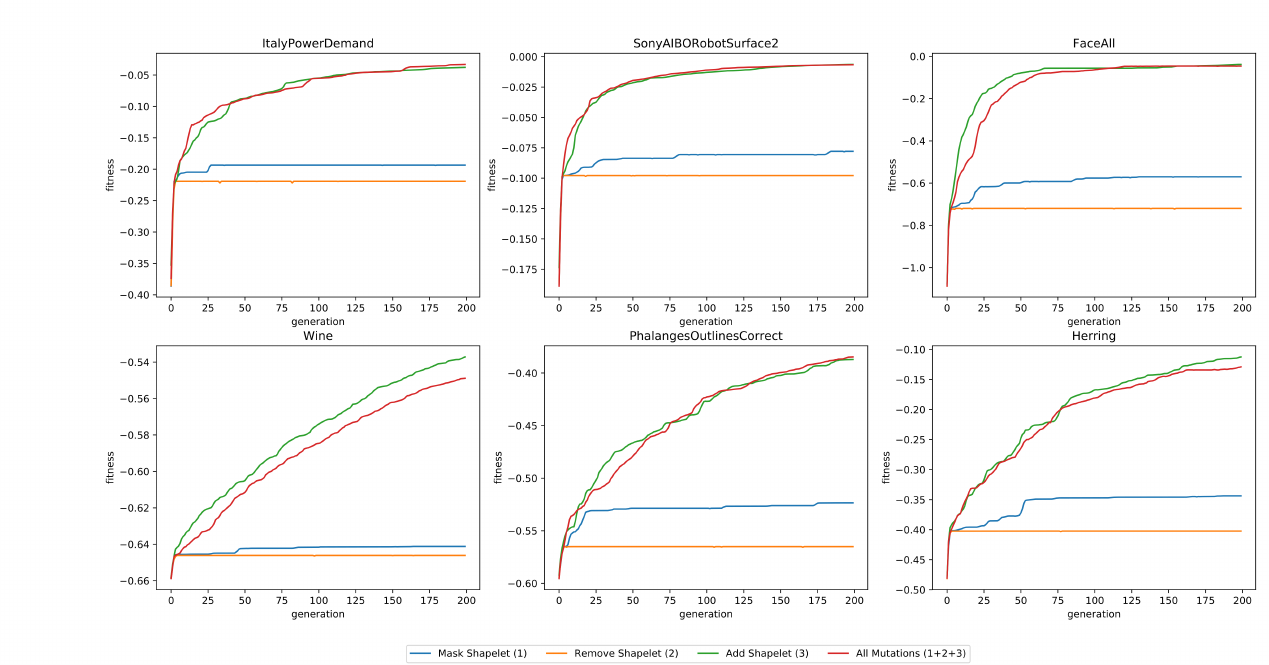
Figure 8. The fitness as a function of the number of generations, for six datasets, using four different configurations of mutation